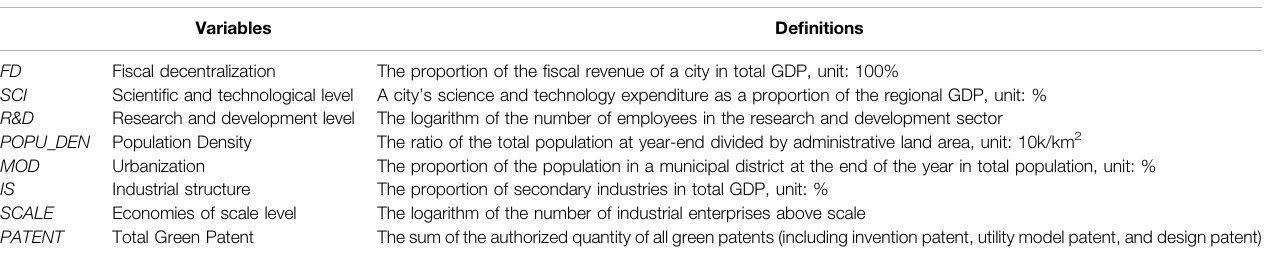
TABLE 1 | De fi nitions of control